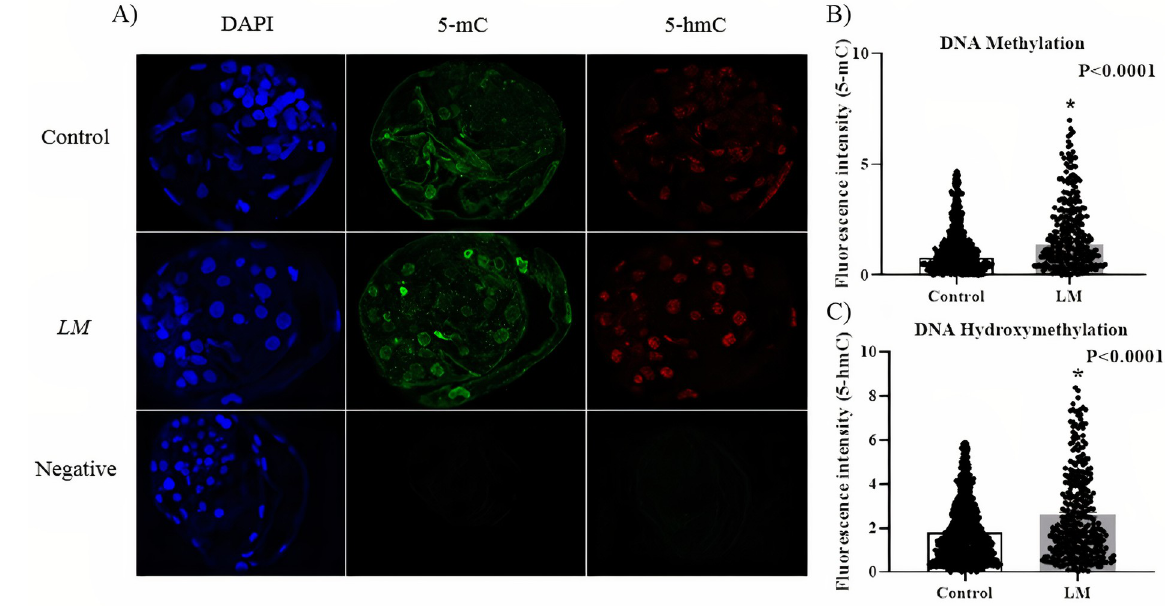
Fig 9. Global levels of DNA methylation and hydroxymethylation in blastocysts cultured in different culture systems. A) Confocal images of blastocysts submitted to different culture systems, conventional (control) or Liquid marble (LM), also a negative control was added to the experiment, without primary antibody labeling (40x objective). B) Global DNA methylation levels in nuclei (n = 909) of D7 blastocysts (n = 7) cultured in conventional system and in nuclei (n = 354) of D7 blastocysts (n = 7) cultured in LM systems. C) Global DNA hydroxymethylation levels in D7 blastocysts. Data are presented as mean ± SEM. Analysis were performed using Wilcoxon test. Asterisk represents statistical difference between groups (P < 0.05).